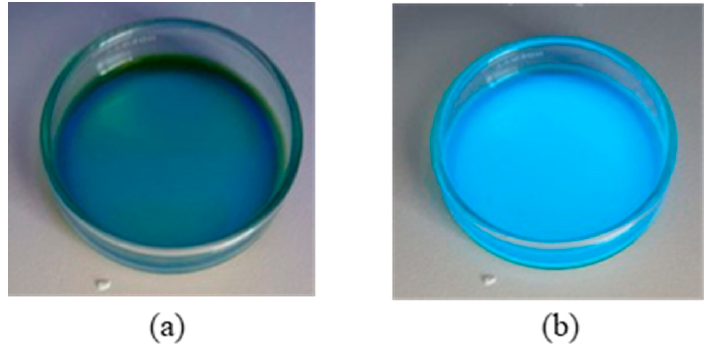
Figure 1. CD under UV light at ( a ) 254 nm and ( b ) 365 nm.